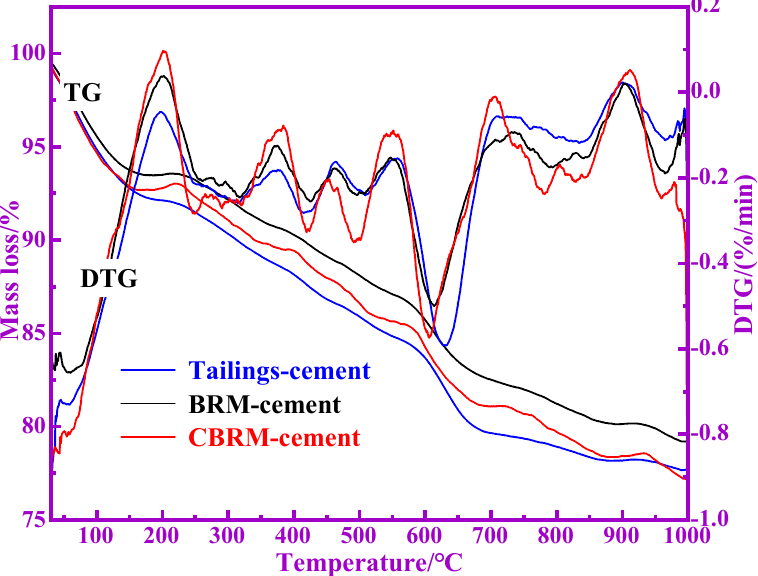
Figure 11. The curves of cumulative pore volume of BRM-cement, CBRM-cement, and Tailings-cement.